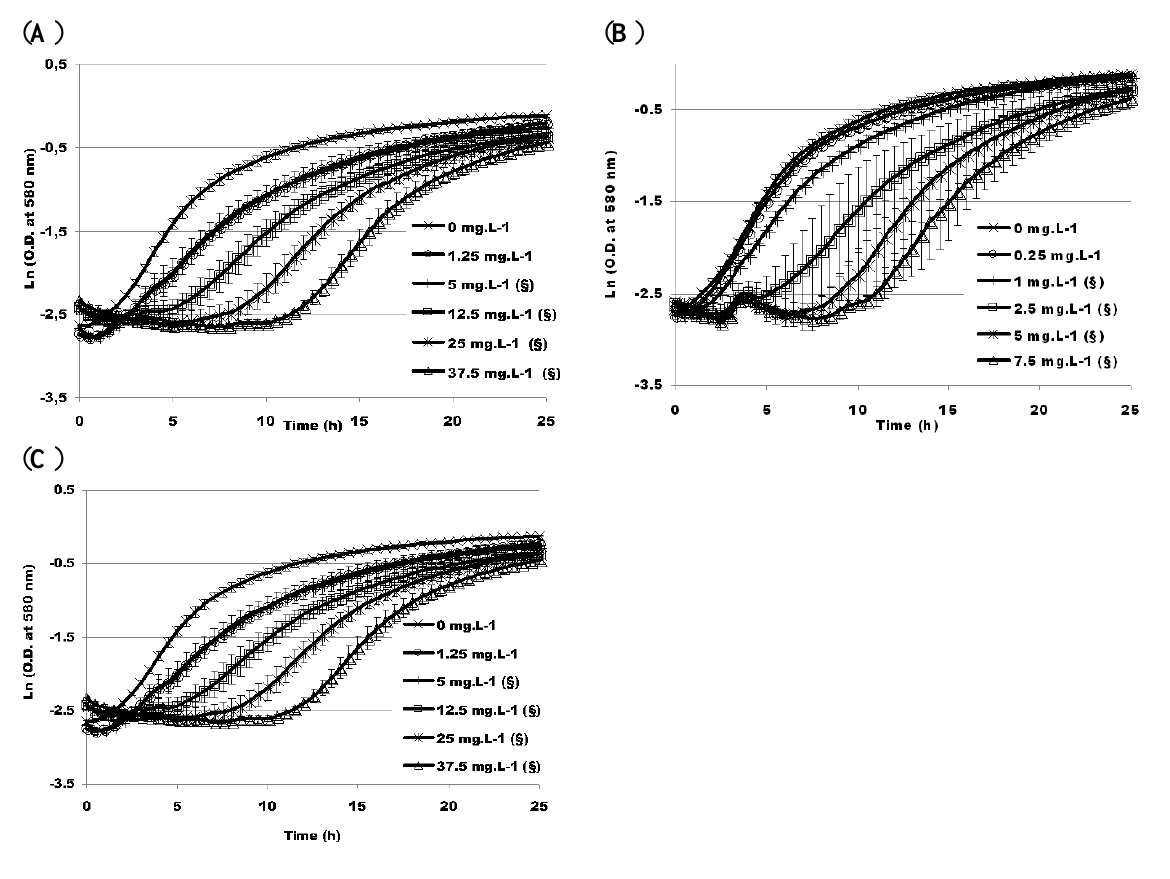
Figure 5. Effect of different PAH concentrations on the growth kinetics of P. fluorescens DSS73 in DMB in oxygen-limited conditions. (§: PAH concentration higher than its solubility limit). ( A ) pyrene; ( B ) fluoranthene; ( C ) phenanthrene. All experiments were done in